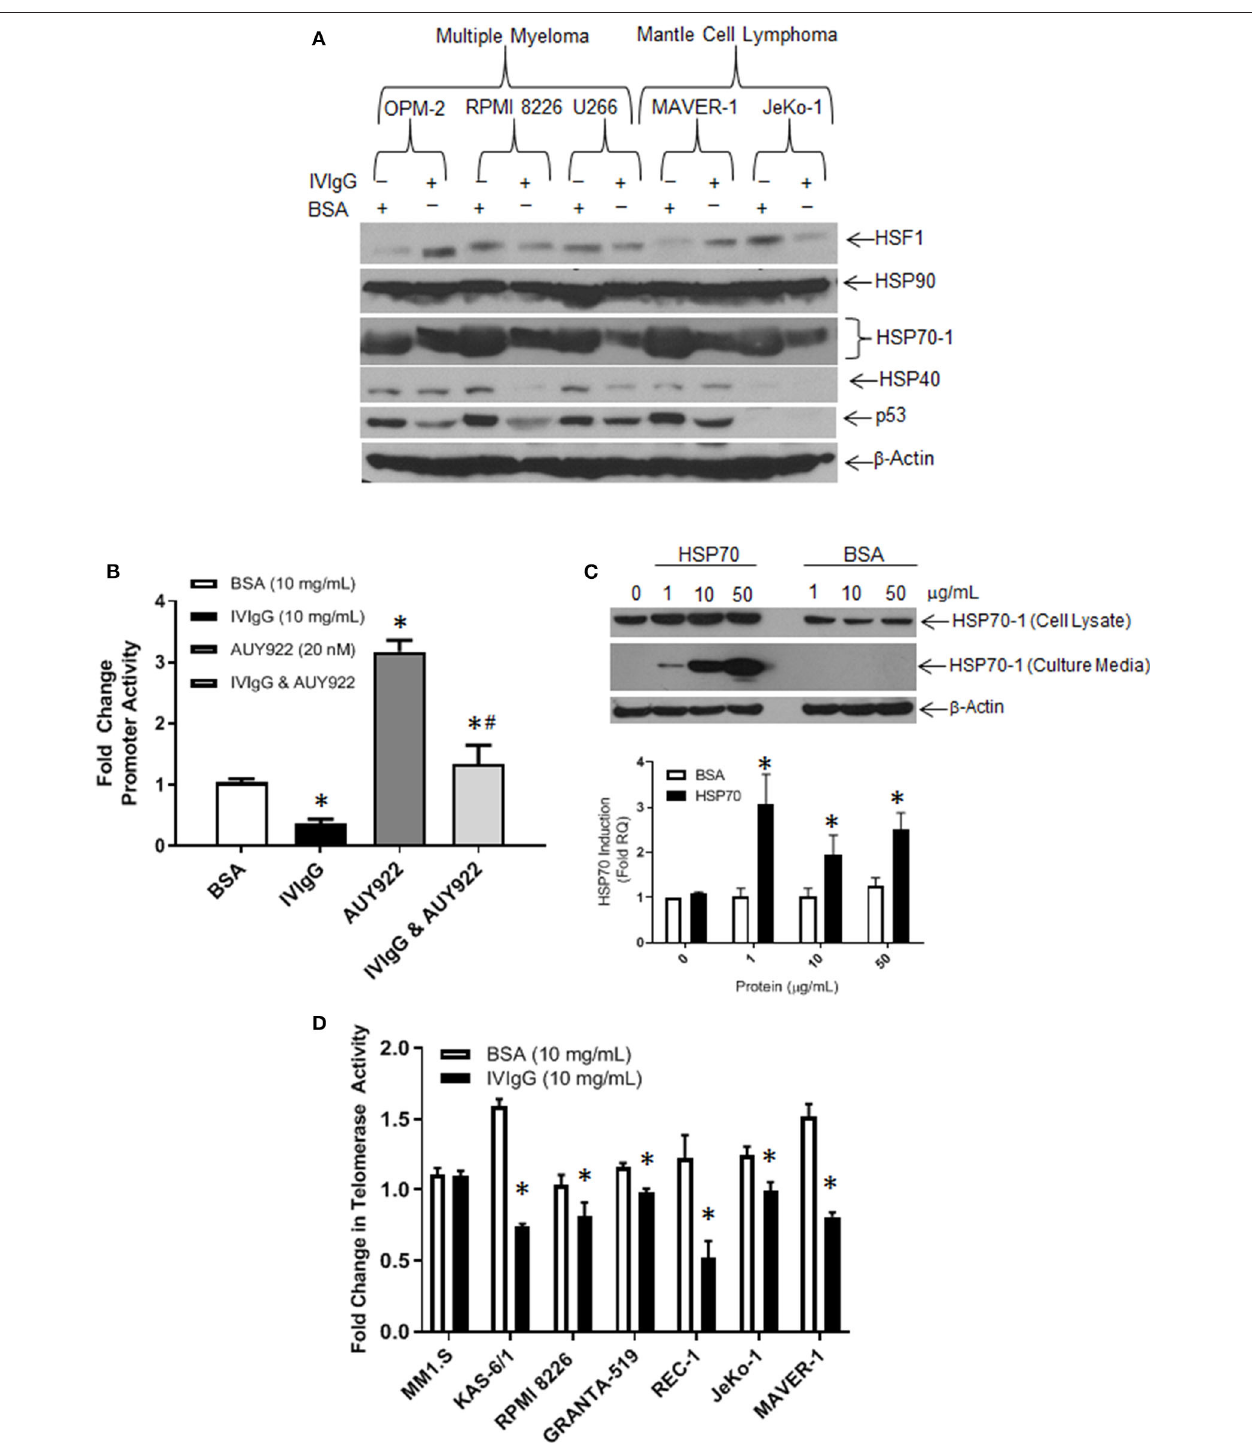
FIGURE 4 | IVIgG suppresses expression of HSP70 and its co-chaperone protein targets. (A ) MM and MCL cell lines were exposed to BSA or IVIgG for 48h, and cell lysates were immunoblotted as indicated. (B) HEK 293T cells were transfected with an HSP70-1 promoter luciferase reporter construct, and promoter activity was monitored following treatment with BSA, IVIgG, AUY922, or IVIgG and AUY922 for 24h. Values were normalized to the BSA control (* denotes p < 0.05 compared to BSA and # denotes p < 0.05 compared to AUY922). (C) RPMI 8226 cells were exposed to recombinant HSP70-1 for 24h in serum-free media, and cell lysates and supernatants were evaluated with the indicated sera, while qPCR was performed on RNA extracted from cells and HSP70-1 transcription measured. (D) Telomerase